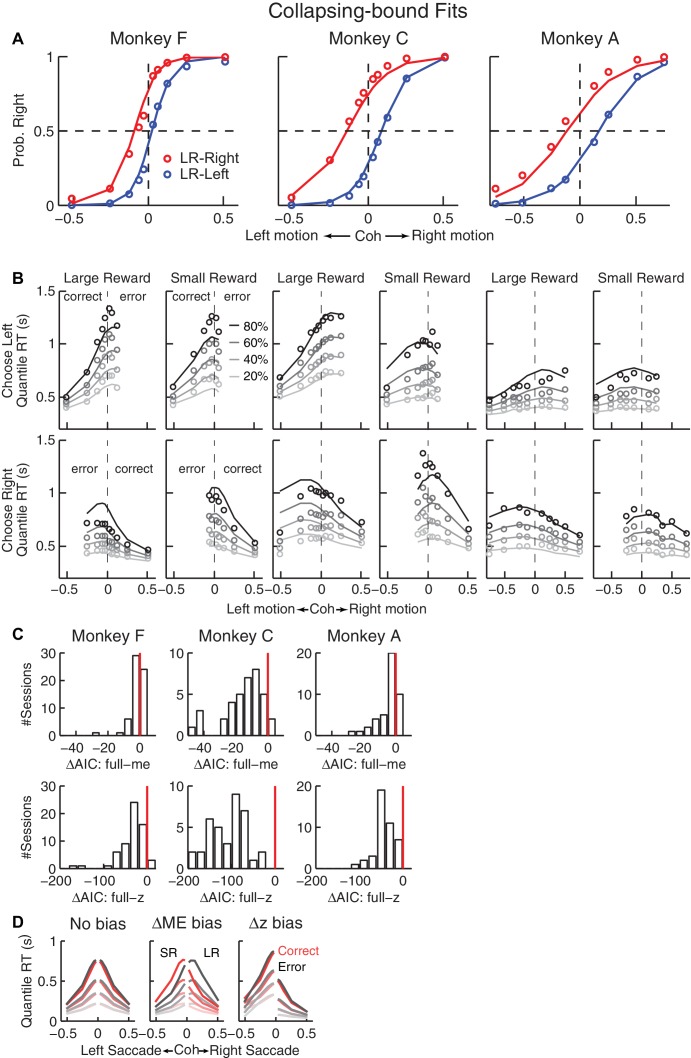
Fits to a DDM with collapsing bounds.(A, B) A DDM with collapsing bounds and both momentary evidence (me) and decision rule (z) biases fit to each monkey’s RT data. Same format as Figure 3. (C) The model that included both me and z adjustments (‘full’) had smaller Akaike Information Criterion (AIC) values than reduced models (‘me’ or ‘z’ only) across sessions. Note also the different ranges of ΔAIC for the full–me and full–z comparisons. The mean ΔAIC (full-me) and ΔAIC (full-z) values are significantly different from zero (Wilcoxon signed rank test, p=0.0007 for Monkey F’s full–me comparison and p<0.0001 for all others). (D), RT distributions as predicted by the DDM with collapsing bounds, using no bias in z or me (left), me > 0 (middle), or z > 0.5 (right). Same format as Figure 3—figure supplement 1A.